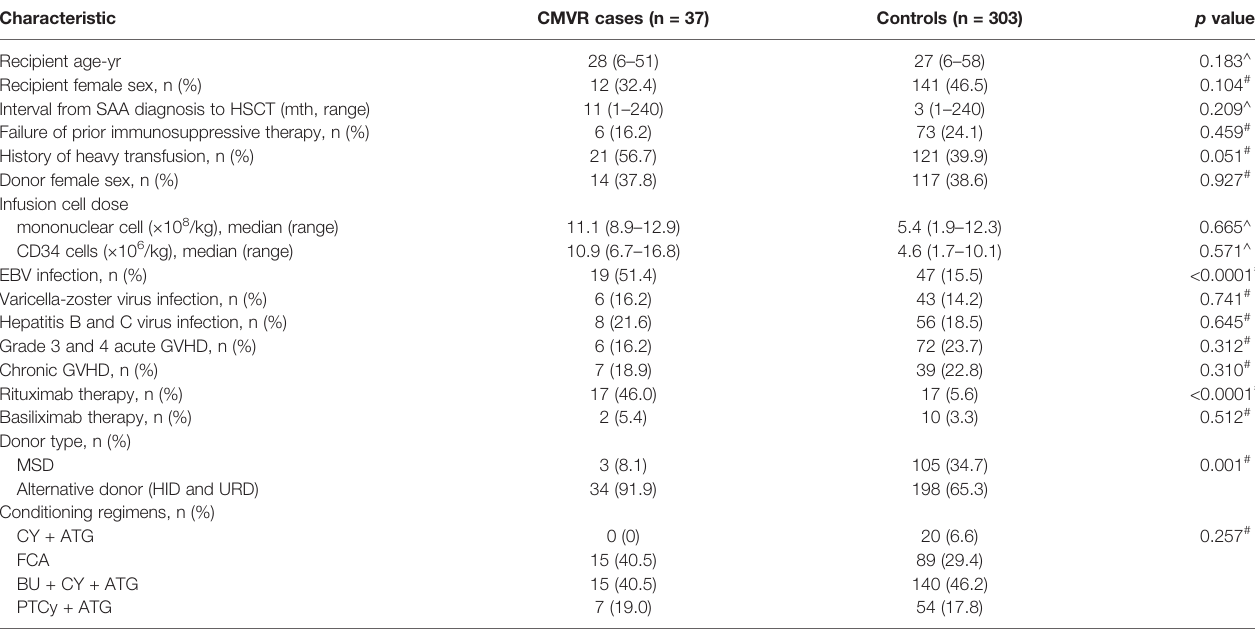
TABLE 1 | General characteristics of the study